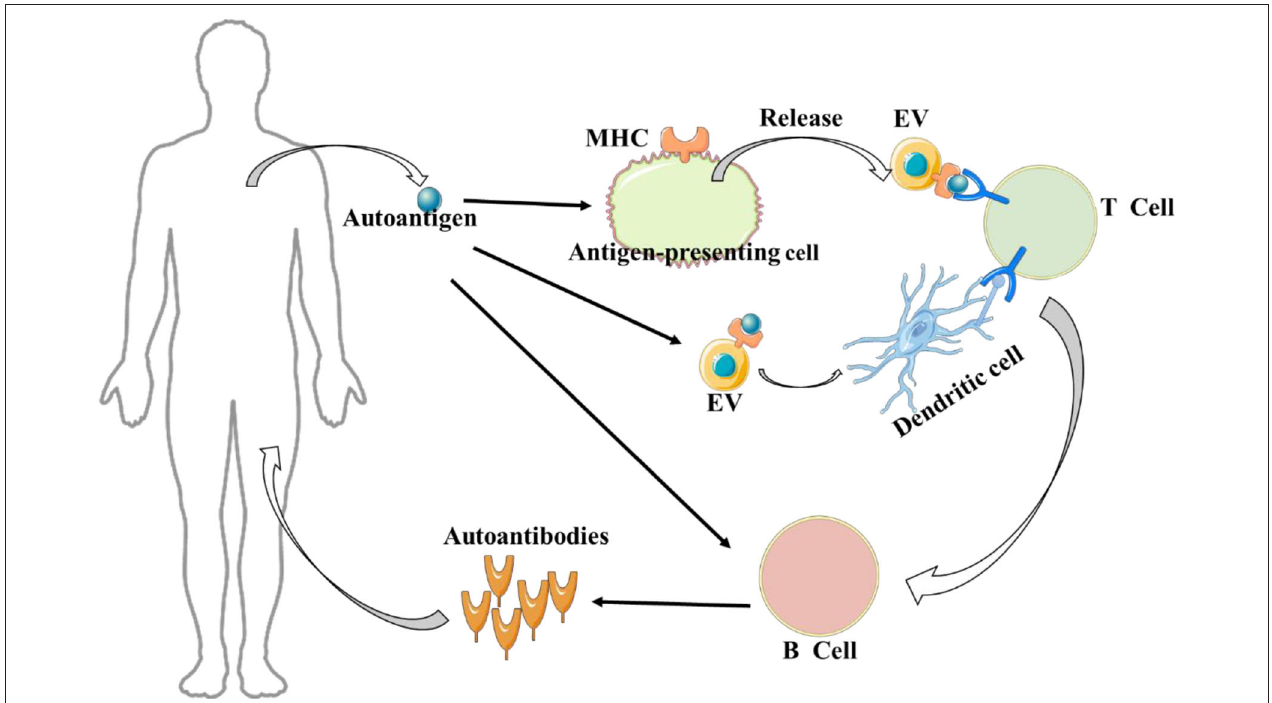
FIGURE 1 | Extracellular vesicles (EVs) and autoimmune disease. It is worth noting, on the one hand, autoantigens can be captured by antigen-presenting cells and transmitted to extracellular vesicles to activate T cells; on the other hand, autoantigens can be directly transmitted to extracellular vesicles to activate T cells in the presence of dendritic